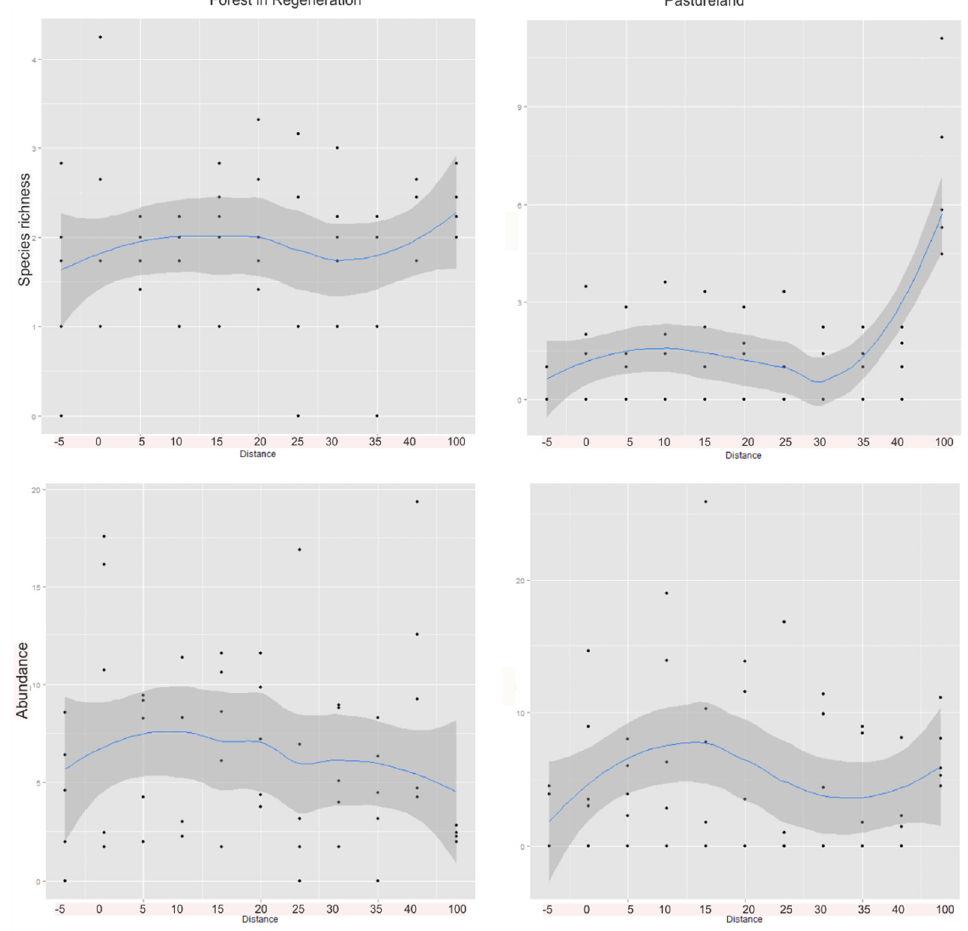
Figure 4. The edge effect in richness of Andean orchids varies according to the type of cover of the neighboring matrix. The effect of distance (in meters) from the edge to the interior on richness ( above ), and abundance ( below ), with distance from edge plotted out in a linear scale. Black horizontal line represents means, and grey shades illustrate the calculation of edge penetration distance, confidence values of 95%.